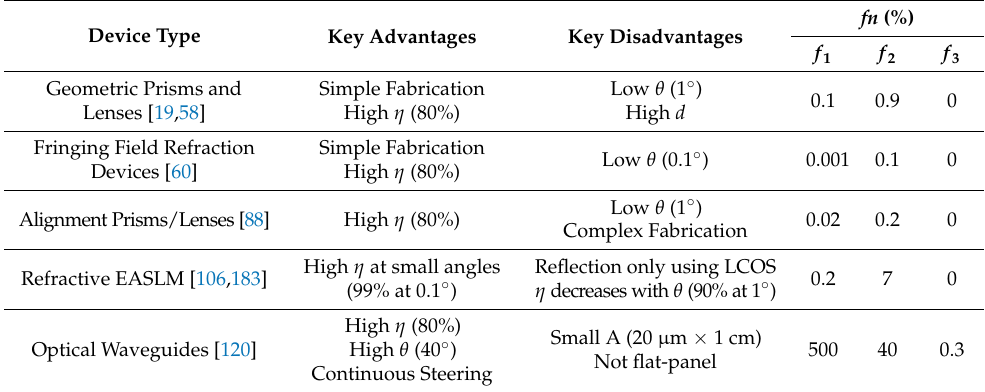
Table 1. Summary of advantages and disadvantages of refractive devices.